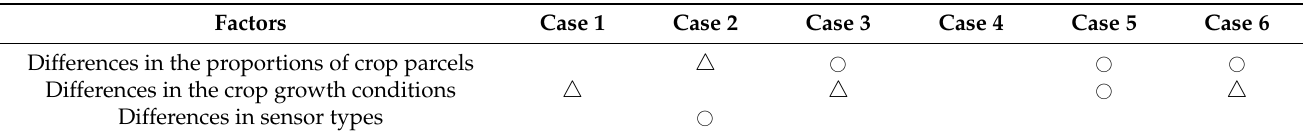
Figure 9. An illustration of the difference in sowing times in the target domain (cases 1 and 3) and growth status between the source and target domains (case 5). The crop type per parcel is shown in white. Table 4. The influential degrees of three domain discrepancy factors for six DA cases. indicate large and small effects,